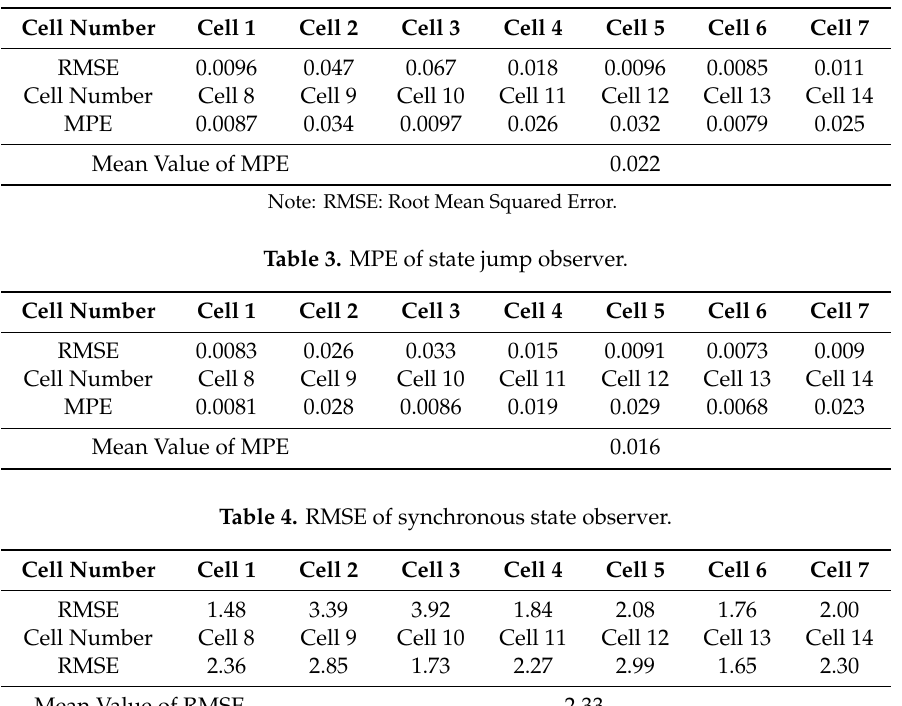
Table 2. Mean Percentage Error (MPE) of synchronous state observer.